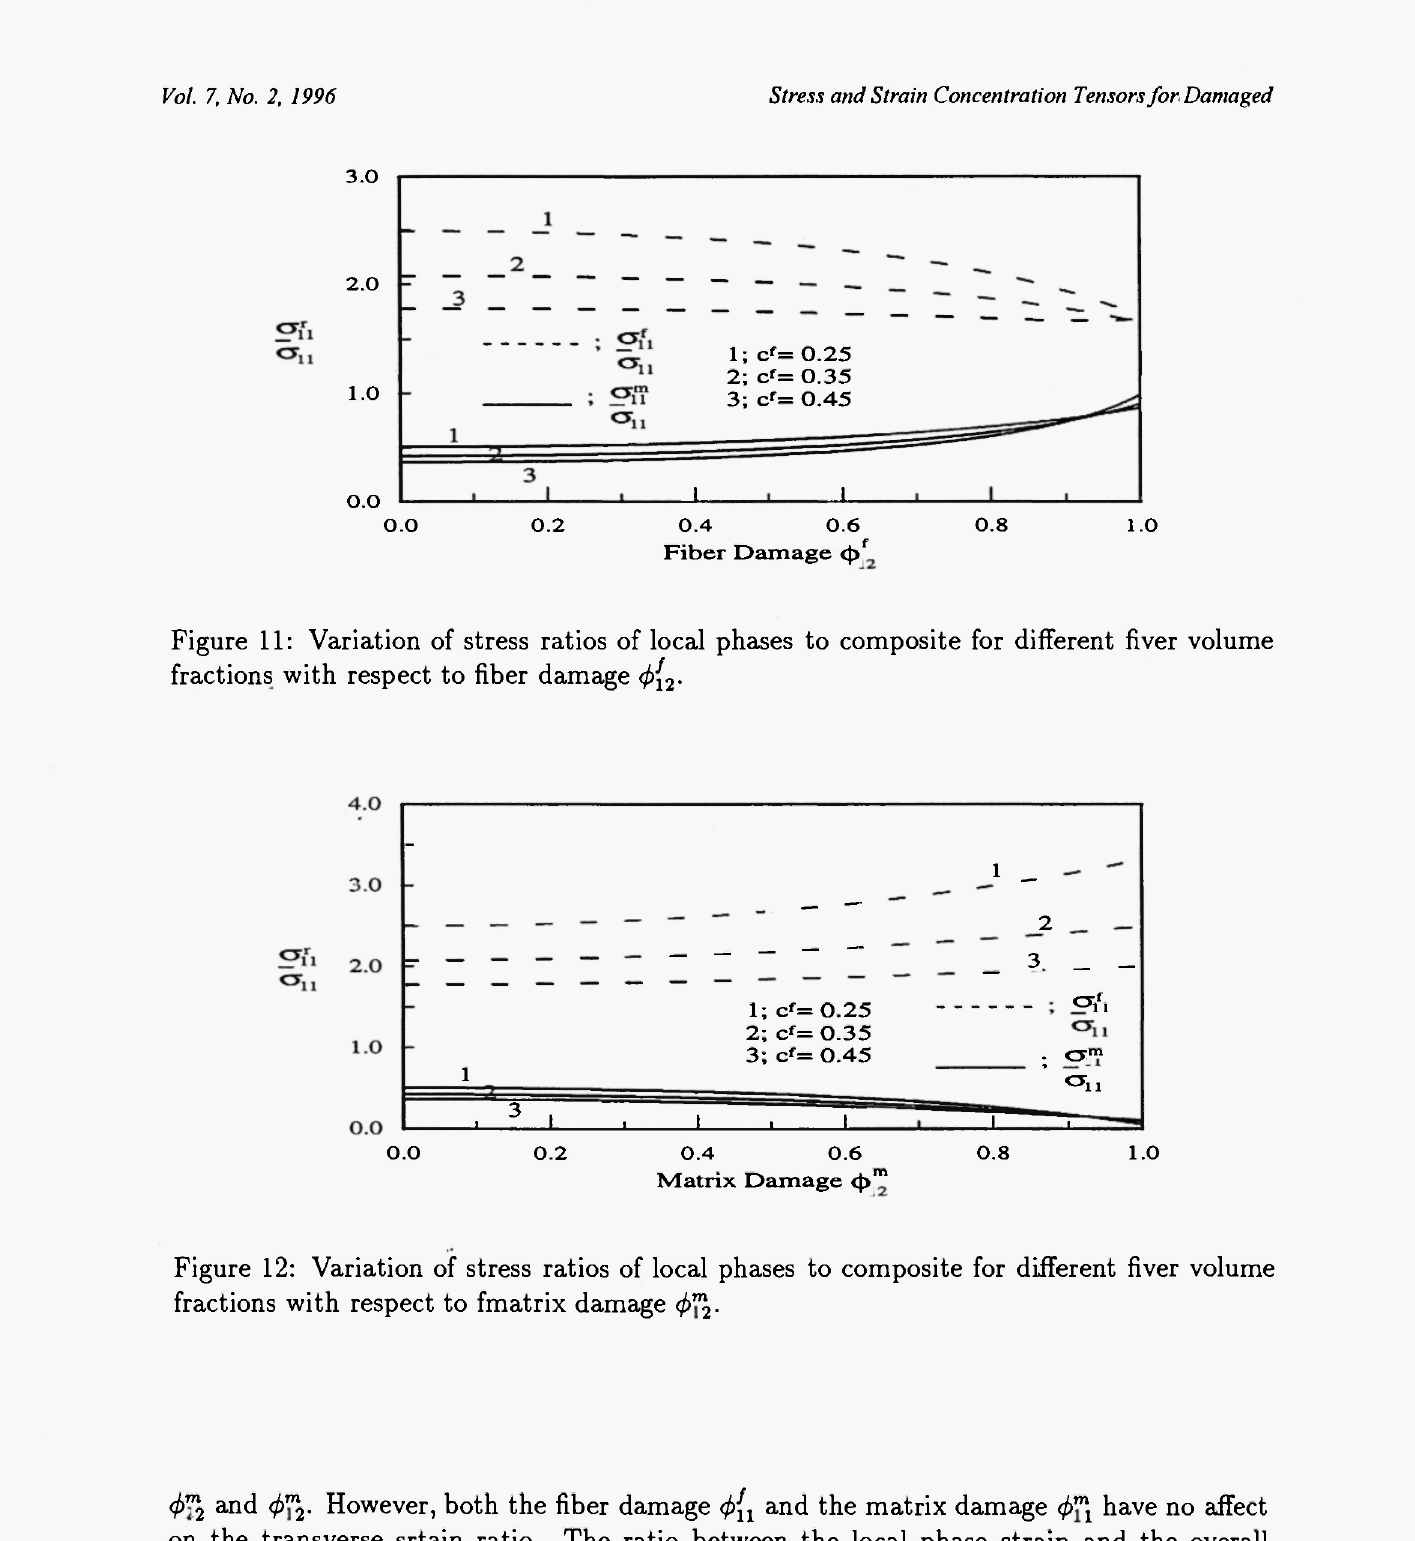
Figure 12: Variation of stress ratios of local phases to composite for different fiver volume fractions with respect to fmatrix damage φ™ 2 .